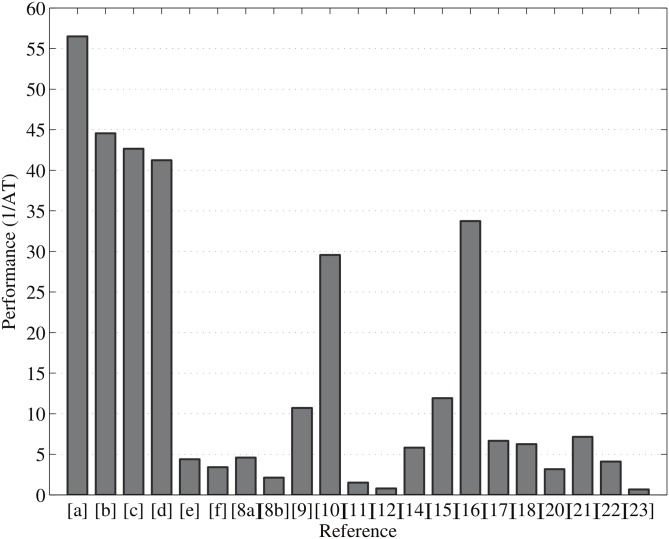
Performance comparison of point multiplication ([a], [b], [c], [d], [e], and [f] represent our work) over GF(2163).